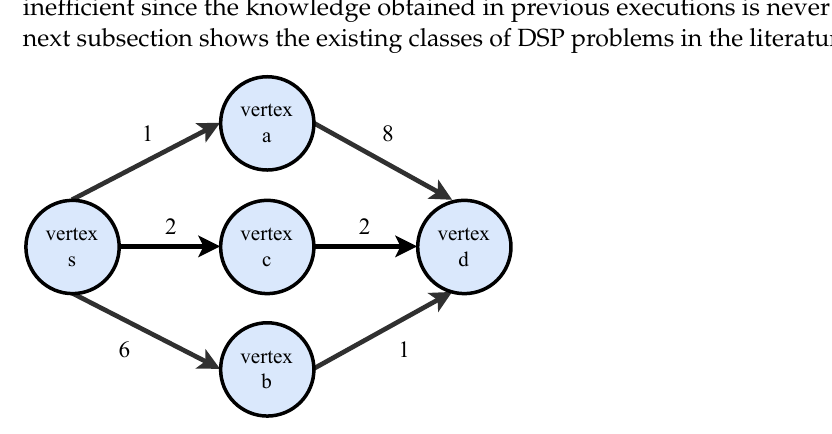
Figure 1. Shortest path graph example with vertices named by the letters s , a , b , c , and d being s the source vertex and d the destination vertex. The number over the edge represents the edge traverse cost between two